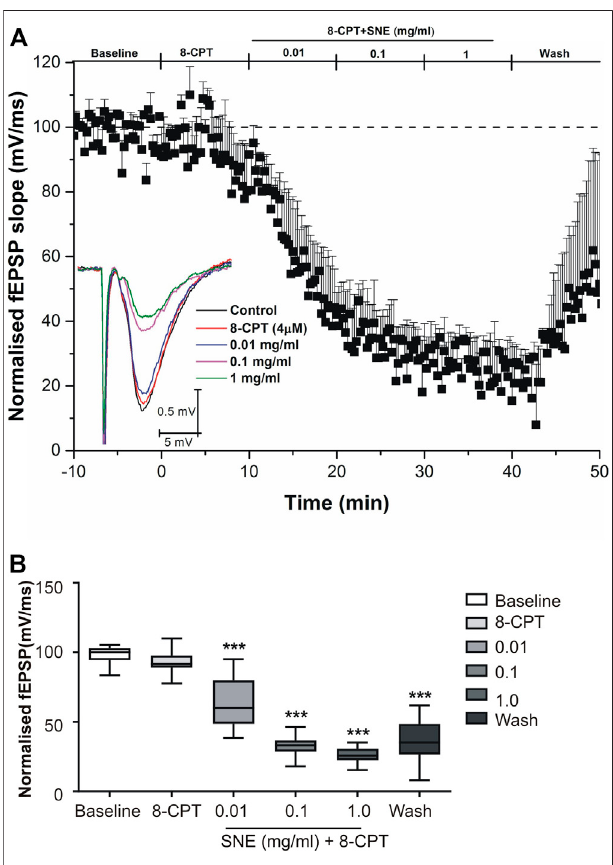
FIGURE 5 | (A) Administration of 8-CPT (4 µM) before SNE (0.01, 0.1 and 1.0 mg/ml) on slope of fEPSPs in rat hippocampal slices after a stable baseline perfused with normal aCSF. (B) The box and whiskers graph is the total effect calculated form the AUCs of the graph above it. Data is mean ± SEM (n (cid:2) 3). *** p < 0.001 compared with baseline, one-way ANOVA followed by a Dunnett ’ s multiple comparison